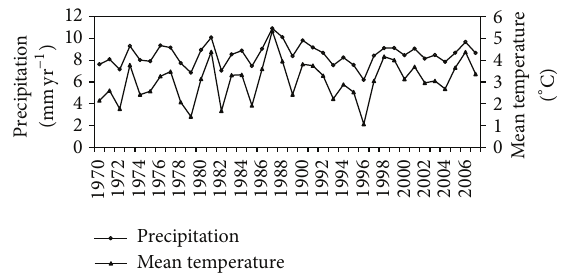
Figure 3: Annual precipitation and mean temperature over the study area from 1970 to